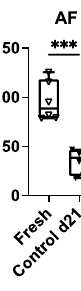
Figure A3. Amount of DNA normalised to wet weight (μg/g) in fresh AF and NP tissues and in samples from the control group after 21 days of organ culture. Results are presented in box plots ( n = 6 IVDs/group). * p < 0.05, *** p < 0.001.